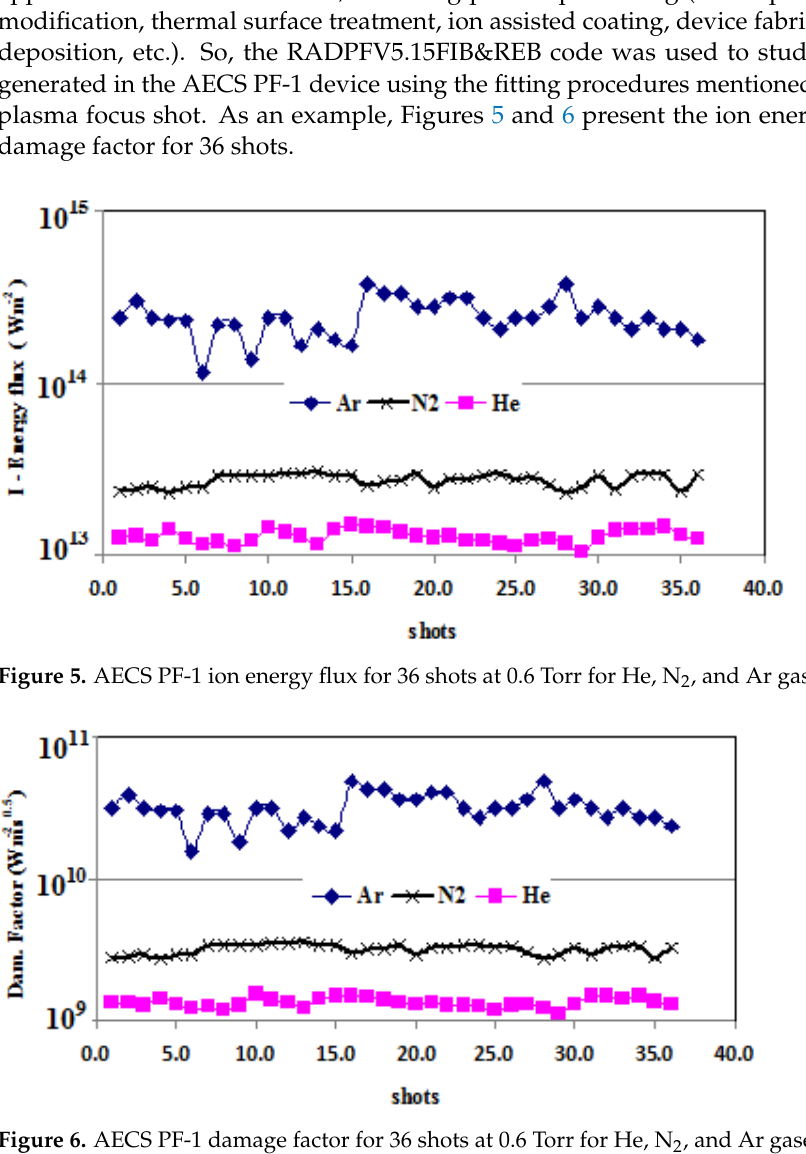
Figure 6. AECS PF-1 damage factor for 36 shots at 0.6 Torr for He, N 2 , and Ar gases.